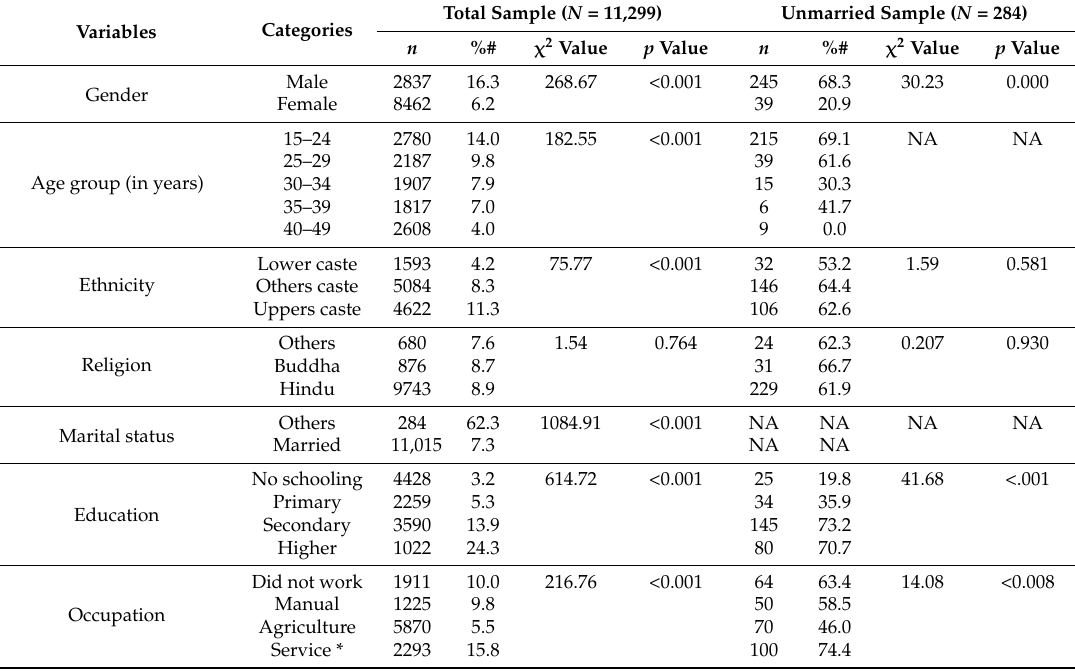
Table 2. Condom Use by Sociodemographic and Behavioral